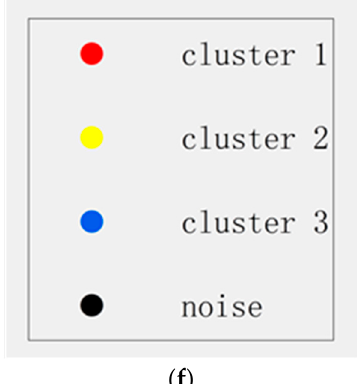
Figure 9. Experimental results. ( a ) Experimental data. ( b ) Clustering result using the CDHC algorithm. ( c ) Clustering result using the CBDT algorithm. ( d ) Clustering result using the DBSCAN algorithm. ( e ) Clustering result using the K-means algorithm. ( f ) Legend.